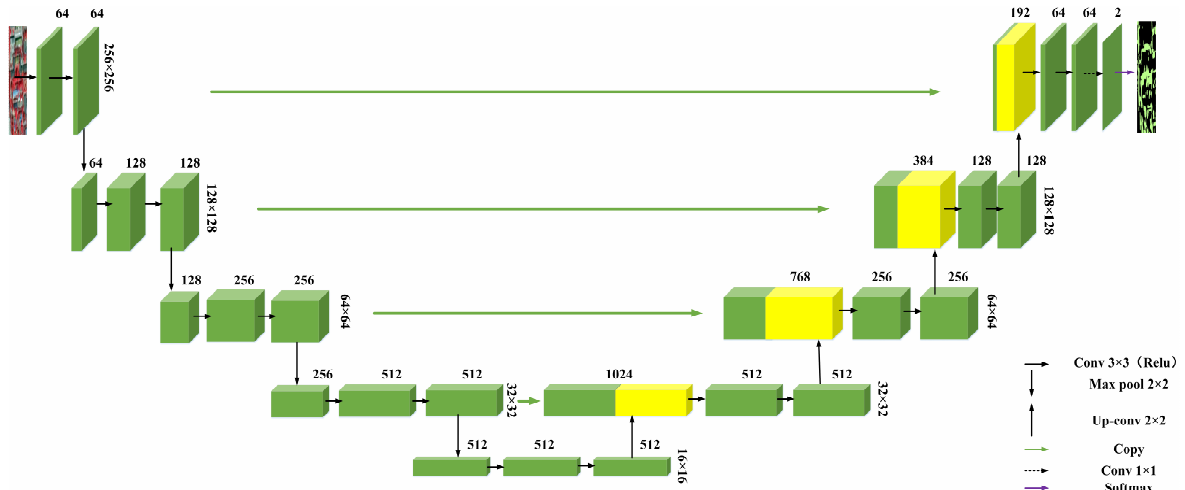
Figure 3. Architecture of U-NET. Each green box represents a multi-channel feature map, the yellow box represents the feature map after transposed convolution. The number of channels is above the box, the size is on the right side of the box. Different arrows represent different operations.